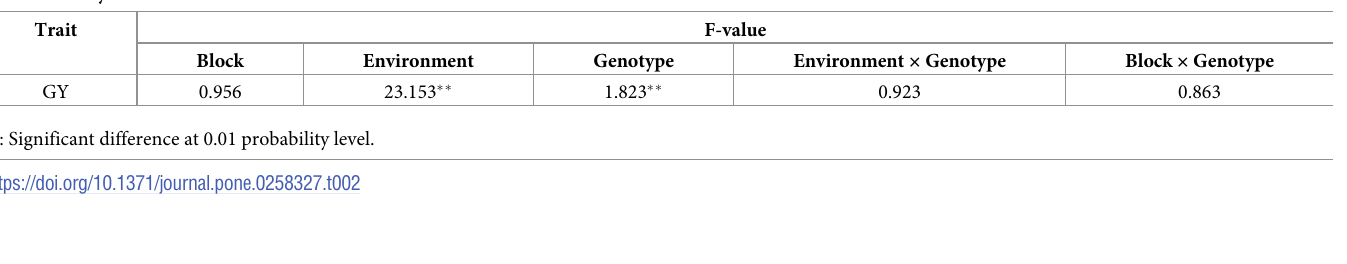
Chang7-2. As described in this table, the same trait of one tester had a similar drift but a signif- icant difference. Furthermore, the differences of the traits between Baoding and Handan indi- cated that GY, PH and EH might be susceptible to environment which meant environment variables should be taken seriously in breeding programs. In addition, GCA of yield ranged from -0.63 to 0.65 in Baoding and from -0.79 to 1.11 in Handan. GCA of PH and EH ranged from -31.38 to 62.77 and from -18.41 to 33.49. Moreover both the highest GCA were resulted by materials 78599. The result of analysis of variance for GY was listed in Table 2. As shown as Table 2, the effects of environment and genotype were significant at 0.01 level, indicating the important roles of both genotypes and environment.